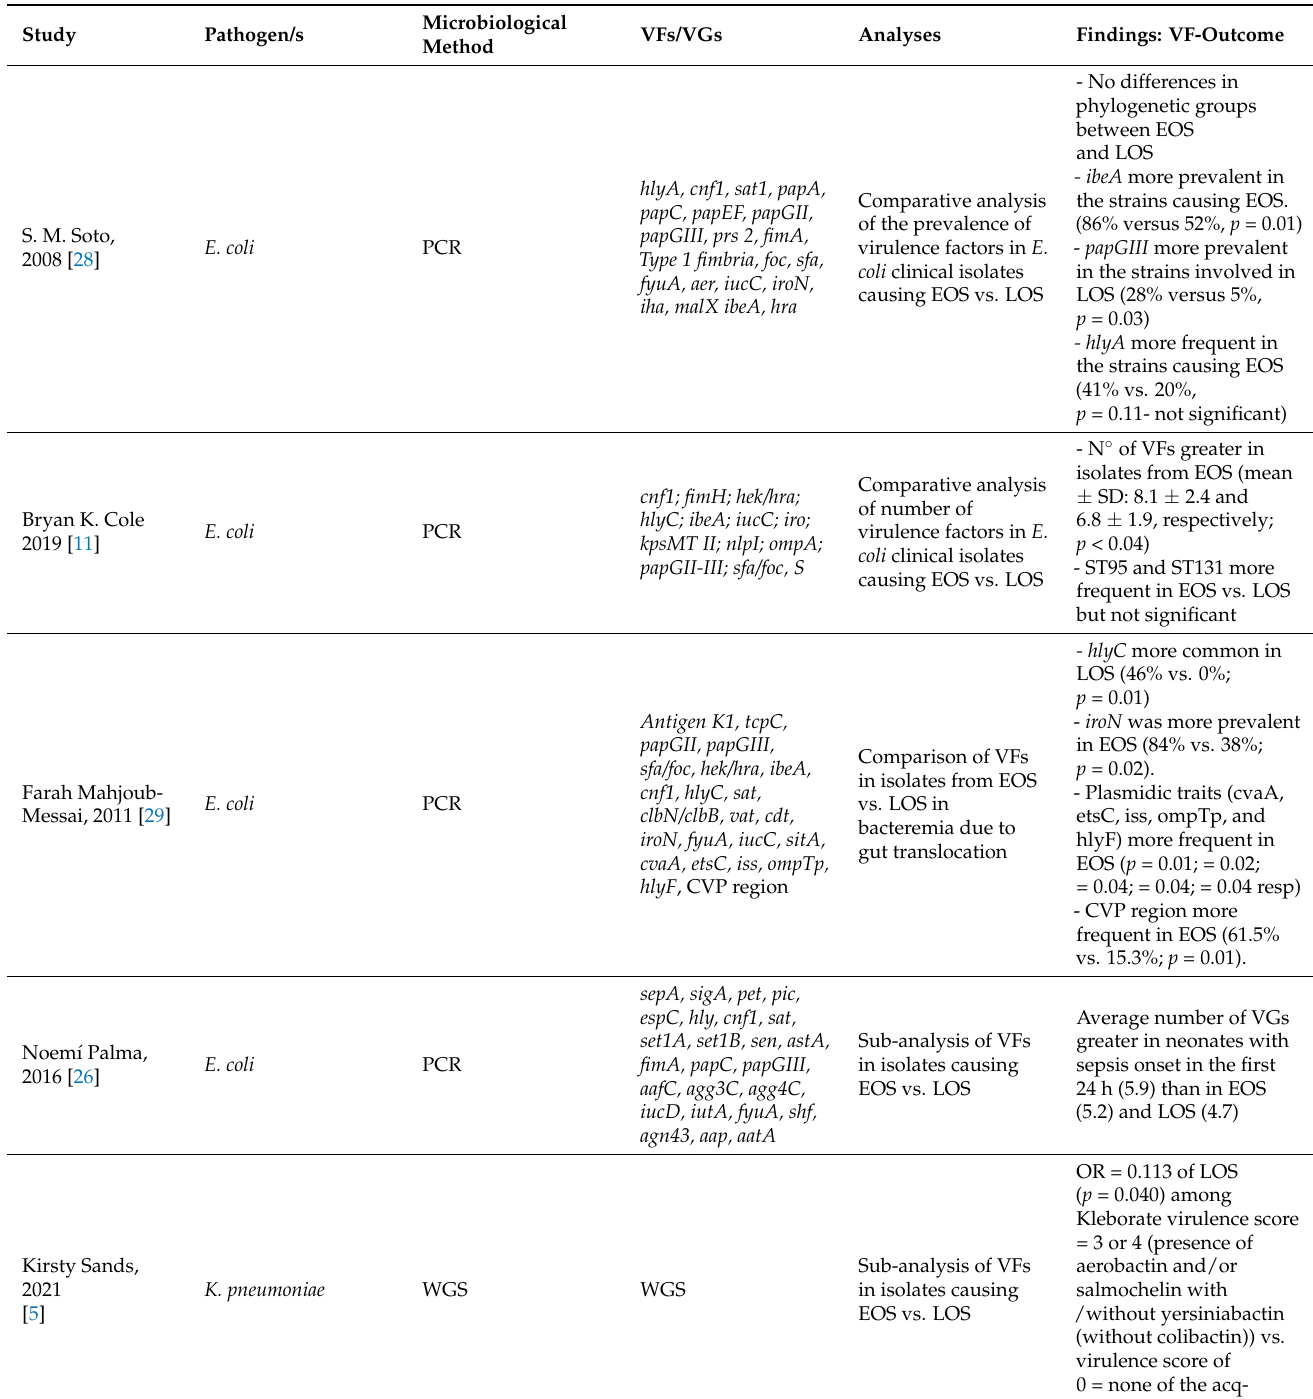
Table 4. Comparison VF profile in EOS vs.